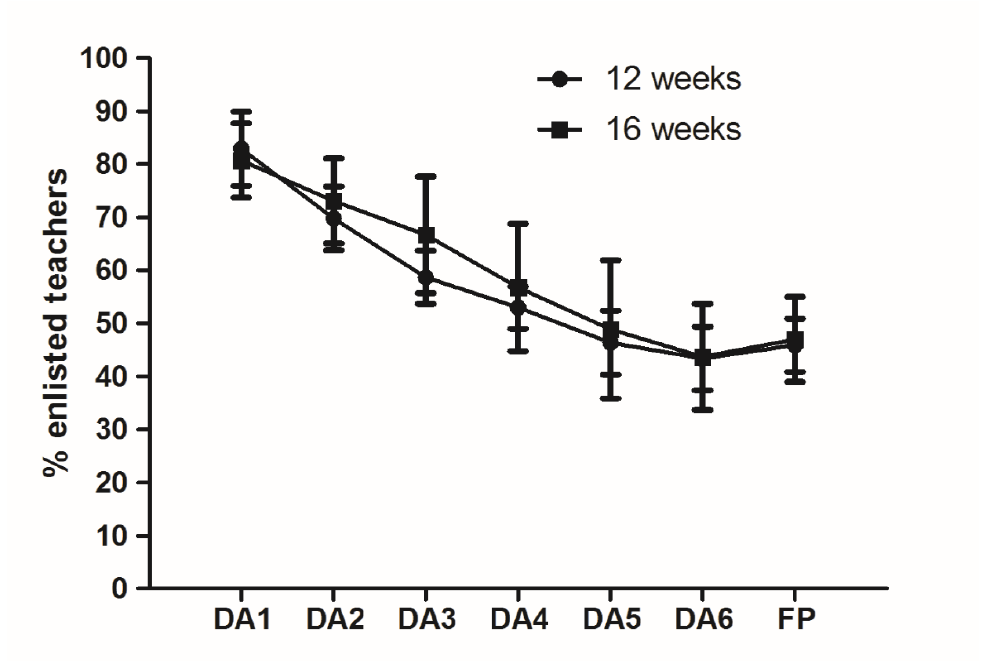
Figure 1. Persistence in online courses as indicated by the percentage of teachers that delivered each distance activity (DA) or the final paper (FP) on the corresponding deadlines.